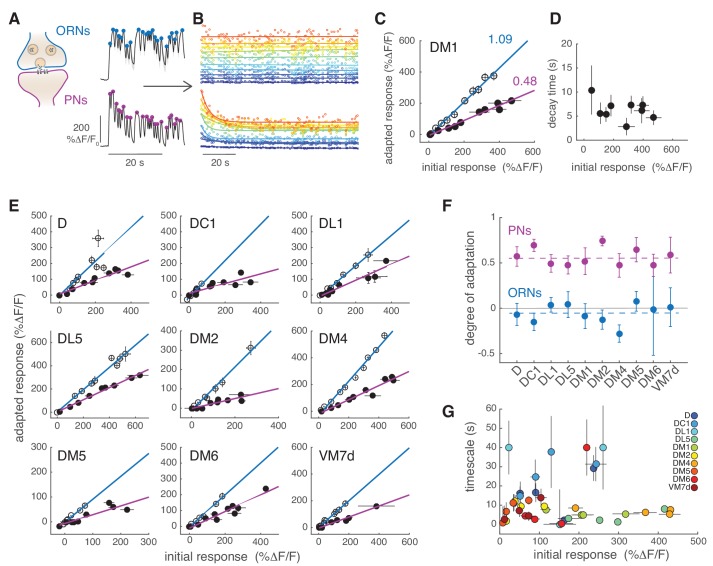
PNs adapt on slow timescales to a sustained, fluctuating odor stimulus.(A) Initial calcium response reported by GCaMP3 to the first 30 s of random odor stimulation in ORNs and PNs within glomerulus DM1. Dots indicate the peak response to each single odor pulse in the random stimulus sequence calculated from the mean ΔF/F (n = 11, 7). (B) All trials for glomerulus DM1 were pooled, sorted by amplitude and averaged in 10 bins spanning the entire response range (see Materials and methods for detail). Peak amplitude of the mean response to each single random pulse is plotted as a function of time and color-coded by the amplitudes for ORNs (top) and PNs (bottom). Continuous lines represent linear (ORNs, rmt=A+Bt) or exponential (PNs, rmt=A+Be-tτ) fits to the time-dependent peak responses. (C) Adapted response as a function of the initial response for ORNs (empty circles) and for PNs (filled circles). Initial and adapted responses were calculated using the fitted parameters. Error bars indicate 95% confidence intervals. Continuous lines represent a linear fit. Numbers indicate slopes of the linear relationship. (D) Adaptation time constants of PN responses for different response amplitudes estimated from the exponential fit. Error bars indicate 95% confidence intervals. (E) Adapted response as a function of the initial response for nine glomeruli and corresponding linear fit. (F) Degree of adaptation estimated as 1 minus the slope of the linear relationship between the adapted and initial response. Dashed lines indicate the mean degree of adaptation across glomeruli: -0.06 ± 0.1 for ORNs and 0.57 ± 0.1 for PNs (mean ± standard deviation). The gray continuous line indicates no adaptation. Error bars indicate 95% confidence intervals (n = 5–11). For all glomeruli, the degree of adaptation is significantly different from zero (p<0.001). (G) Adaptation timescales estimated for four odorant concentrations, color-coded by glomerulus, and plotted as a function of response amplitude. Error bars indicate 95% confidence intervals (n = 5–11). See also Figure 4—figure supplement 1. Note that a slow decay in activity that outlasted the stimulus duration was observed at the lowest and highest concentrations in DL1 and at the highest concentration in DM6. For these measurements we report confidence intervals for an exponential fit with the maximum timescale (which was set to 40 s in our analysis).